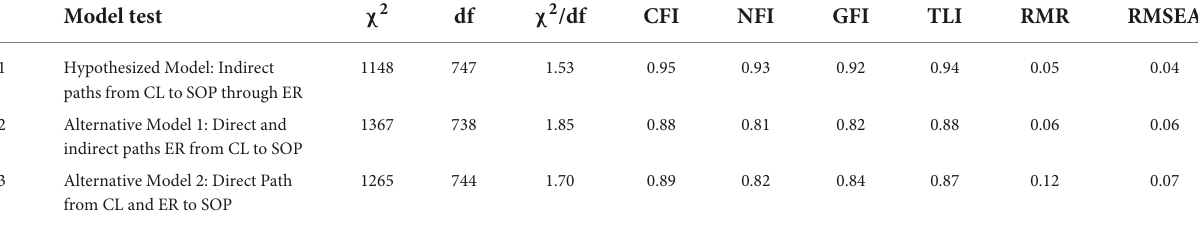
TABLE 5 Comparison of alternative structural models.